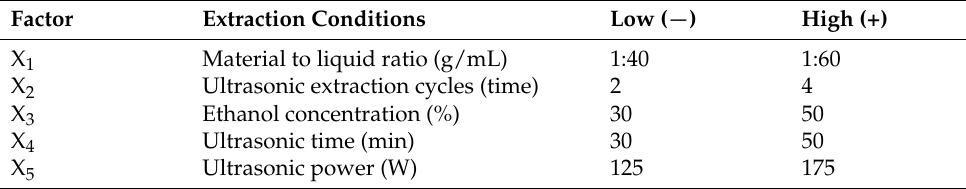
Table 5. Plackett-Burman design factor